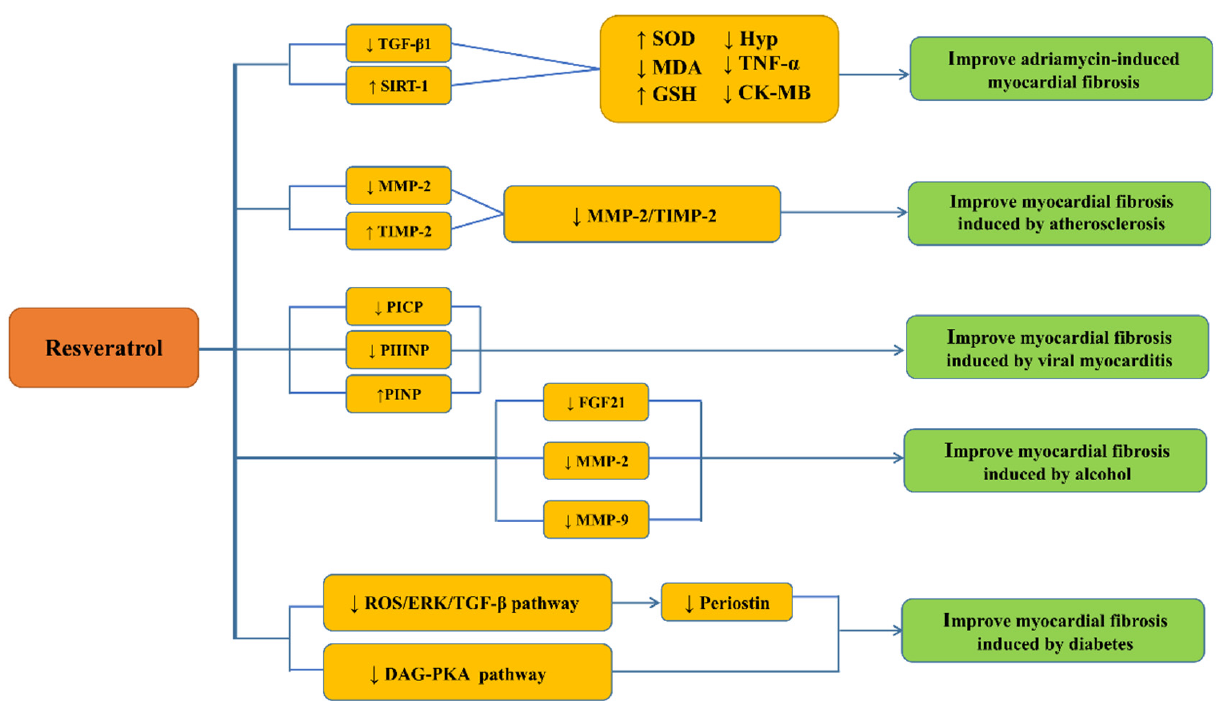
Figure 1. Potential mechanisms of resveratrol against cardiac fibrosis. ↓ : a decrease; ↑ : an increase. Transforming growth factor β 1 (TGF β 1), Sirtuins-1(SIRT-1), superoxide dismutase (SOD), malondialdehyde (MDA), glutathione (GSH), phenolic oxidative coupling protein (Hyp), transforming growth factor α (TGF- α ), creatine kinase-MB(CK-MB), matrix metalloproteinase-2 and 9 (MMP-2 and 9), tissue inhibitor of metalloproteinases-2 (TIMP-2), carboxyterminal propeptide of type I procollagen(PICP), amino-terminal propeptide of type III procollagen (PIIINP), aminoterminal propeptide of type I procollagen (PINP), fibroblast growth factor 21(FGF21), reactive oxygen species (ROS), extracellular signal-regulated kinase (ERK), diacylglycerol (DAG), protein kinase A (PKA).